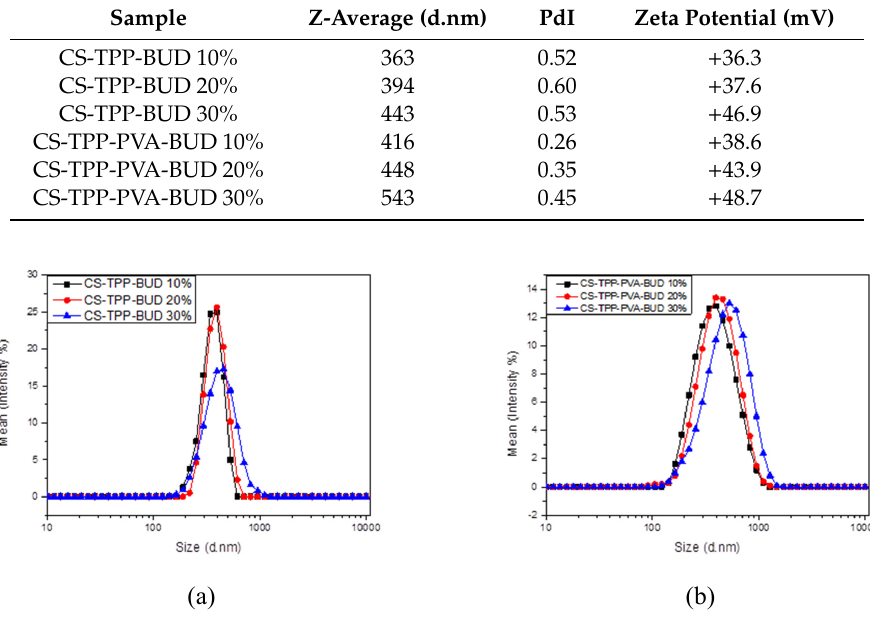
Figure 2. Particle size distribution measured by dynamic light scattering (DLS) of ( a ) CS-TPP-BUD and ( b ) CS-TPP-PVA-BUD nanoparticles for three di ff erent BUD concentrations, 10, 20 and 30